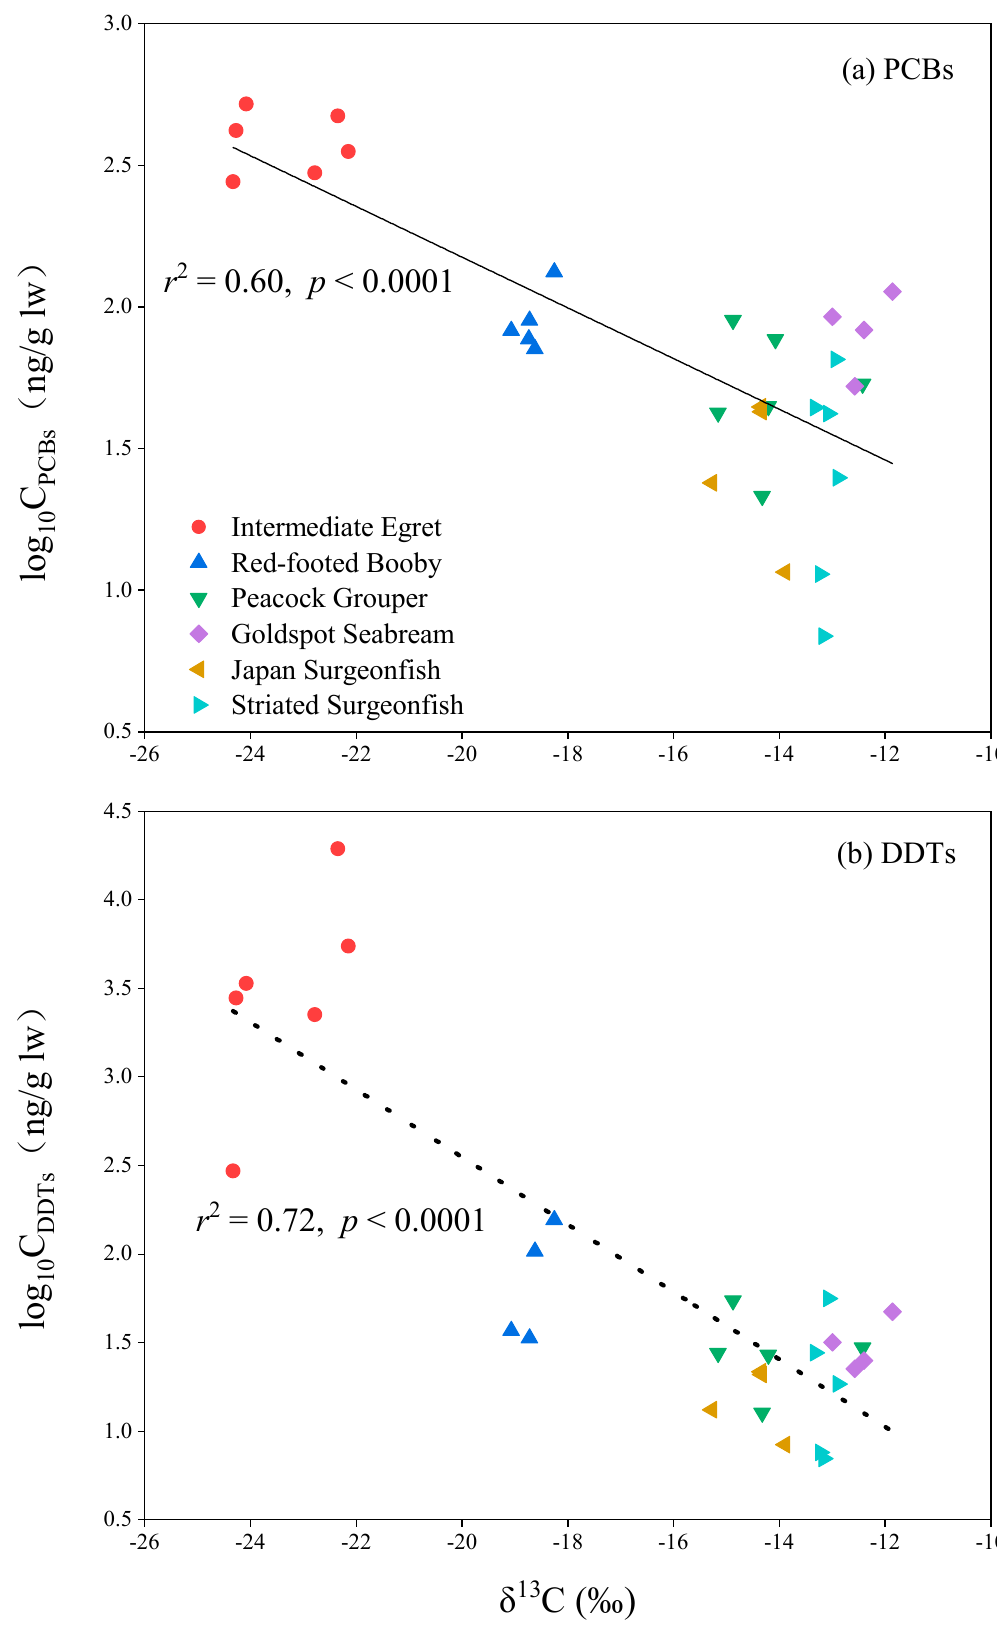
Figure 3. The relationship between concentrations of PCBs and DDTs and δ 13 C values.